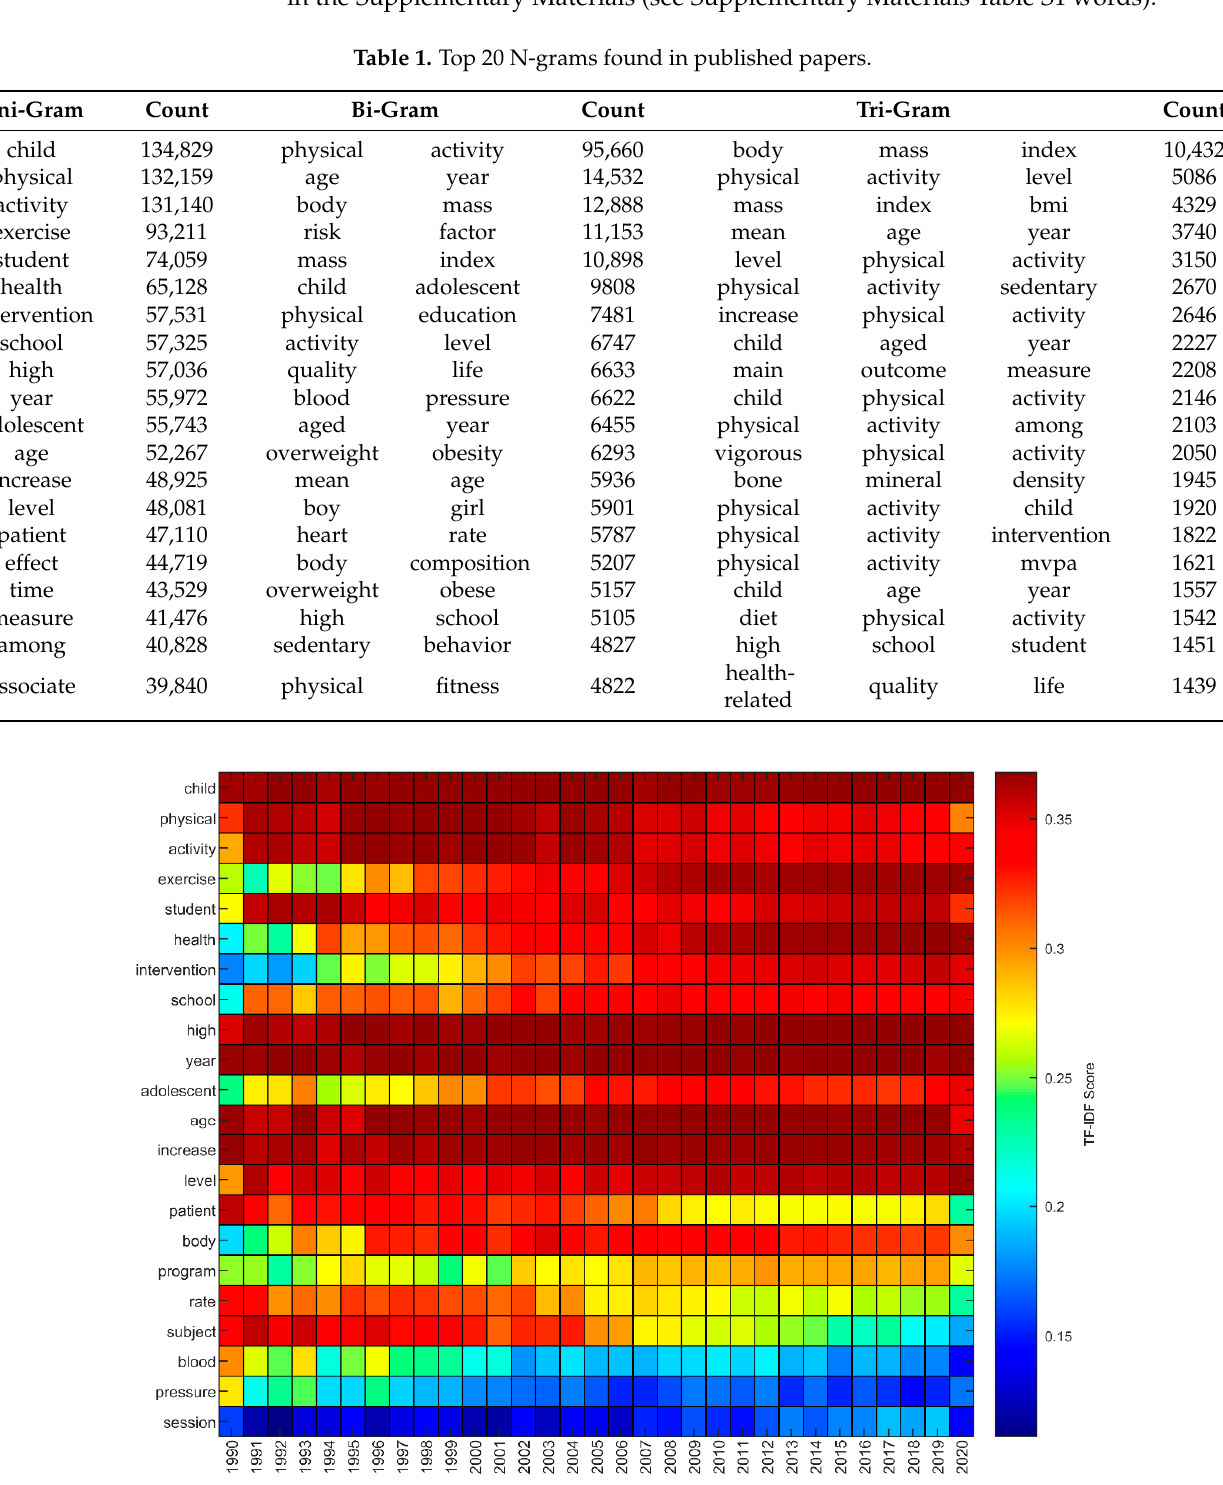
Figure 3. Word dynamics over the last 30 years. TF-IDF represent how important a word is across a set of documents. A high score shows a higher relevance of the word in the document corpus (warmer colors).